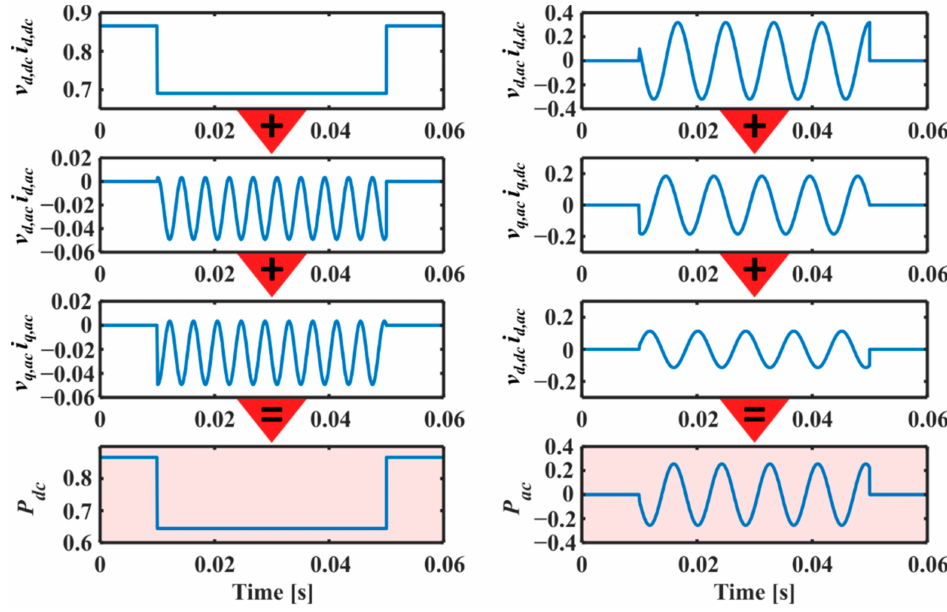
Figure 6. Active power theoretical analysis (per unit) under unbalanced grid